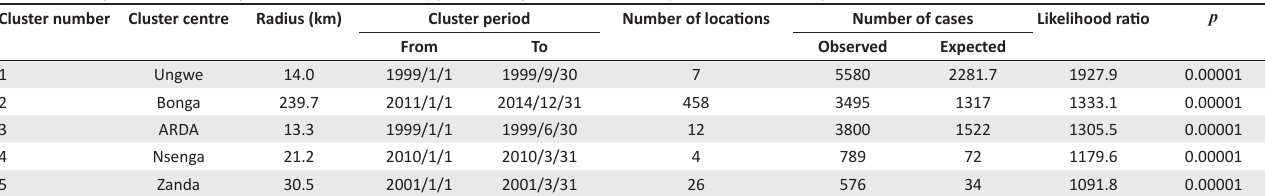
FIGURE 4: Likely clusters of clinical dermatophilosis cases in Zimbabwe for the period 1995–2014. TABLE 1: Likely clusters from a space–time scan statistic (space–time permutation model) of clinical